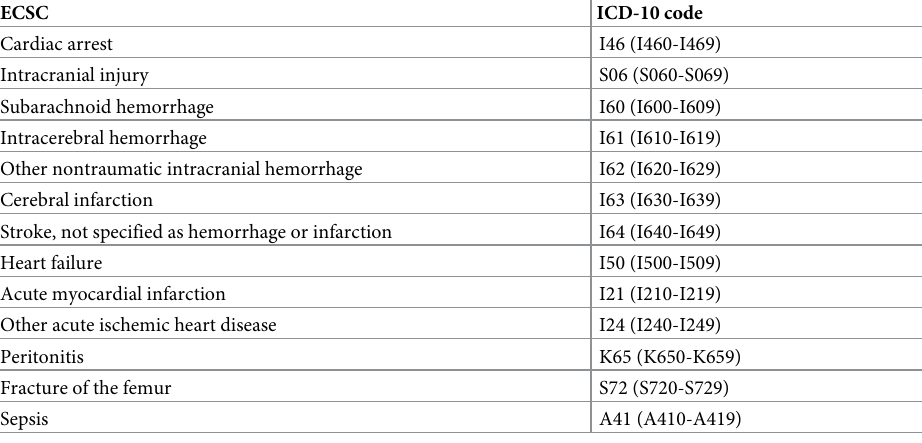
Table 1. ICD codes of the 13 emergency care–sensitive